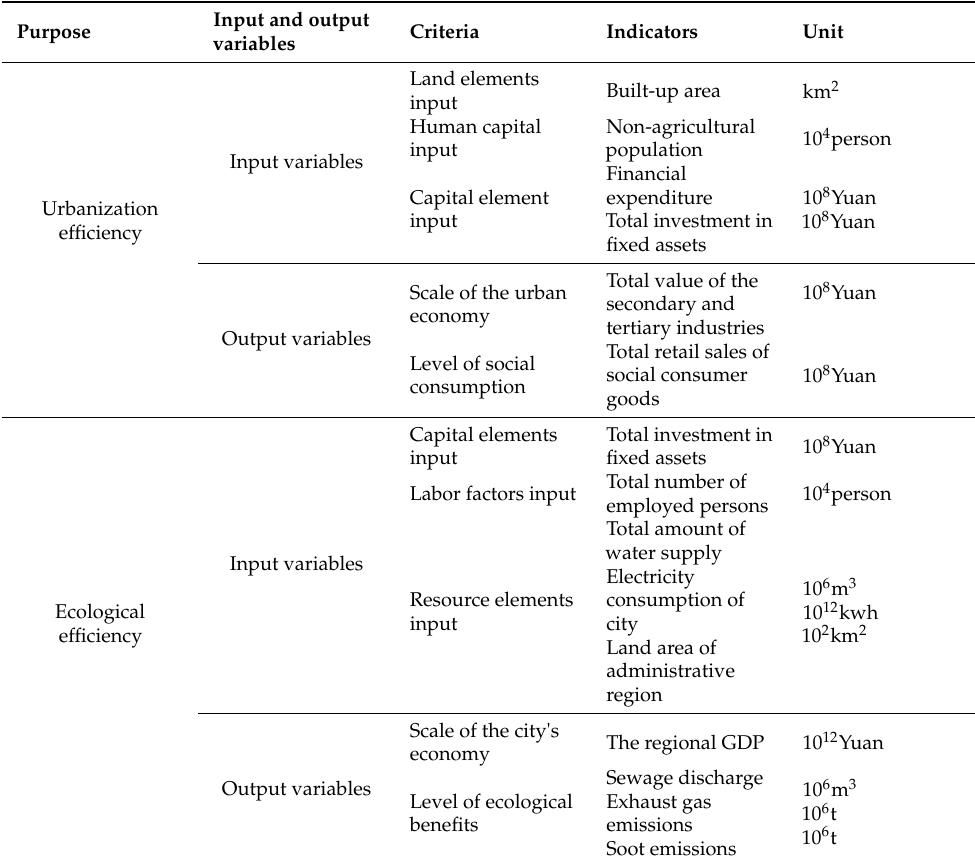
Table 1. Evaluation index system of urbanization efficiency and ecological efficiency.